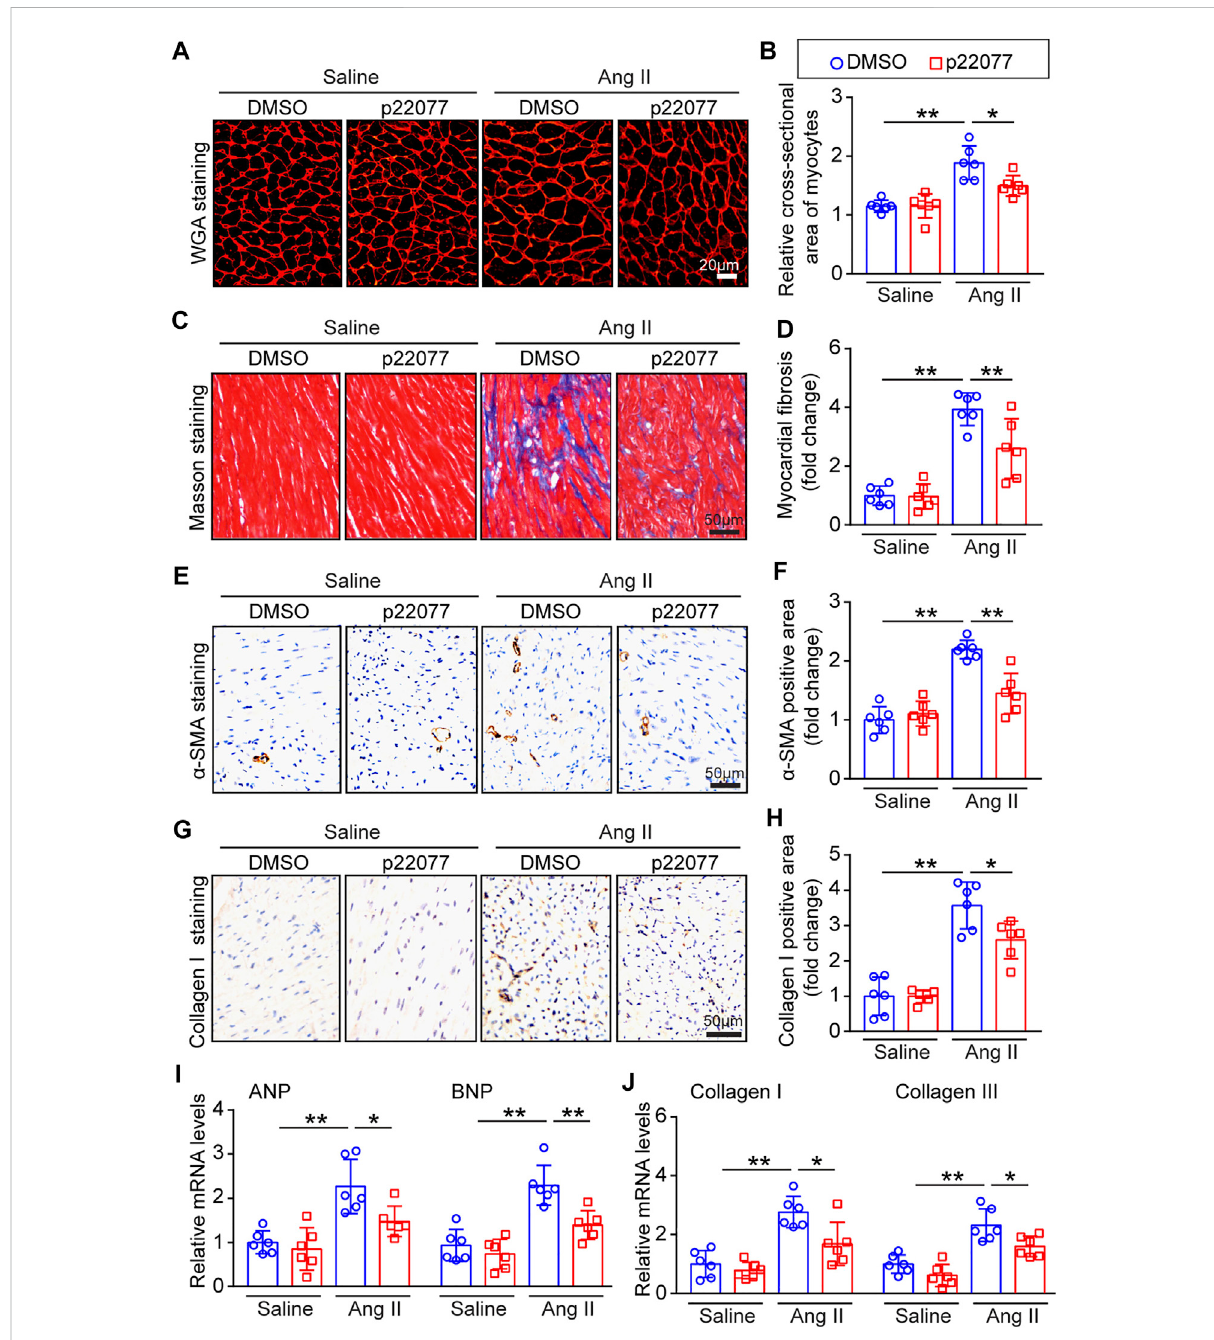
FIGURE 4 Administration of p22077 attenuates Ang II-induced cardiac hypertrophy and cardiac fi brosis. (A,B) Histological examination of cardiac hypertrophybyTRITC-WGA staining (Left)and quanti fi cationoftherelativemyocytecross-sectionalarea (200 cellscountedper heart, Right; n =6). Scale bars, 20 μ m. (C,D) Histological examination of myocardial fi brosis detected by Masson ’ s trichrome staining (Left) and quanti fi cation of the relative fi brosisarea(Right; n =6).Scalebars,50 μ m. (E,F) Representative IHCandquanti fi cation of α -SMA-positive area( n =6micepergroup). Scale bars, 50 μ m. (G,H) Representative IHC and quanti fi cation of Collagen I-positive area ( n = 6 mice per group). Scale bars, 50 μ m. (I,J) qPCR analysisofANP,BNP,collagenIandcollagenIIImRNAlevelsinthehearttissues.ThedataarenormalizedtotheGAPDHexpression( n =6pergroup). The data are presented as the mean ± SD, and n represents the number of animals per group. * p < 0.05, and ** p <